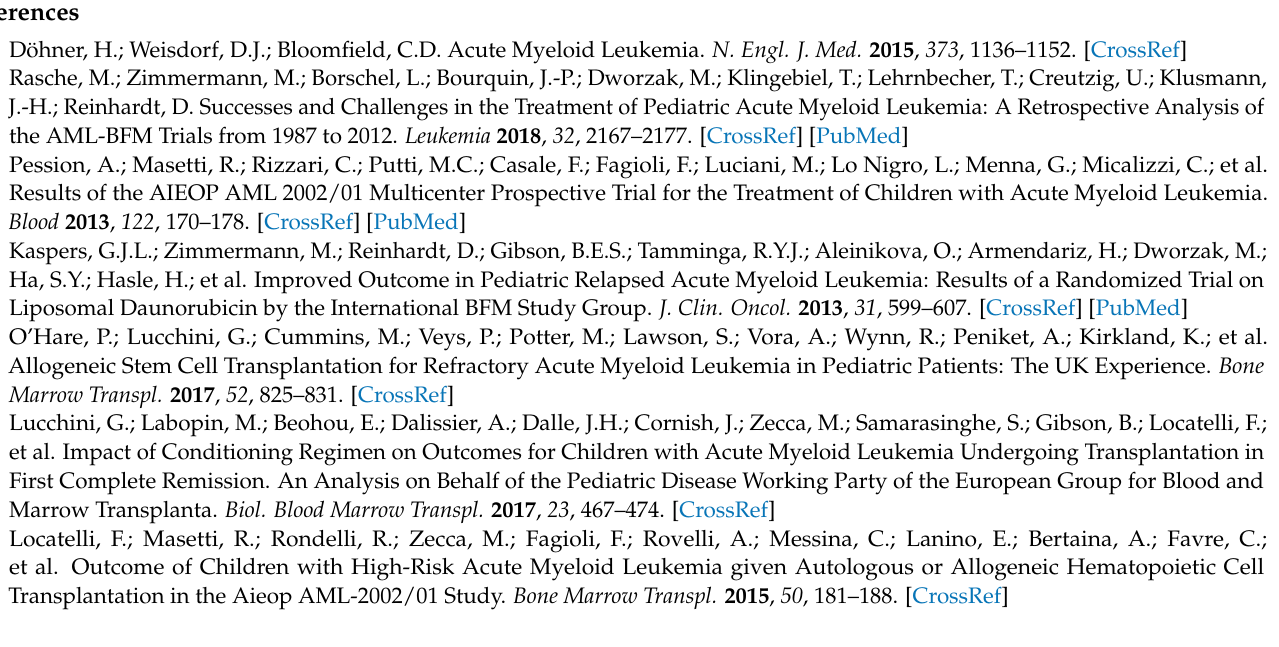
Table S2: Clinical, molecular, and transplant variables in each qPCR-MRD-defined group; Table S3: Multivariate